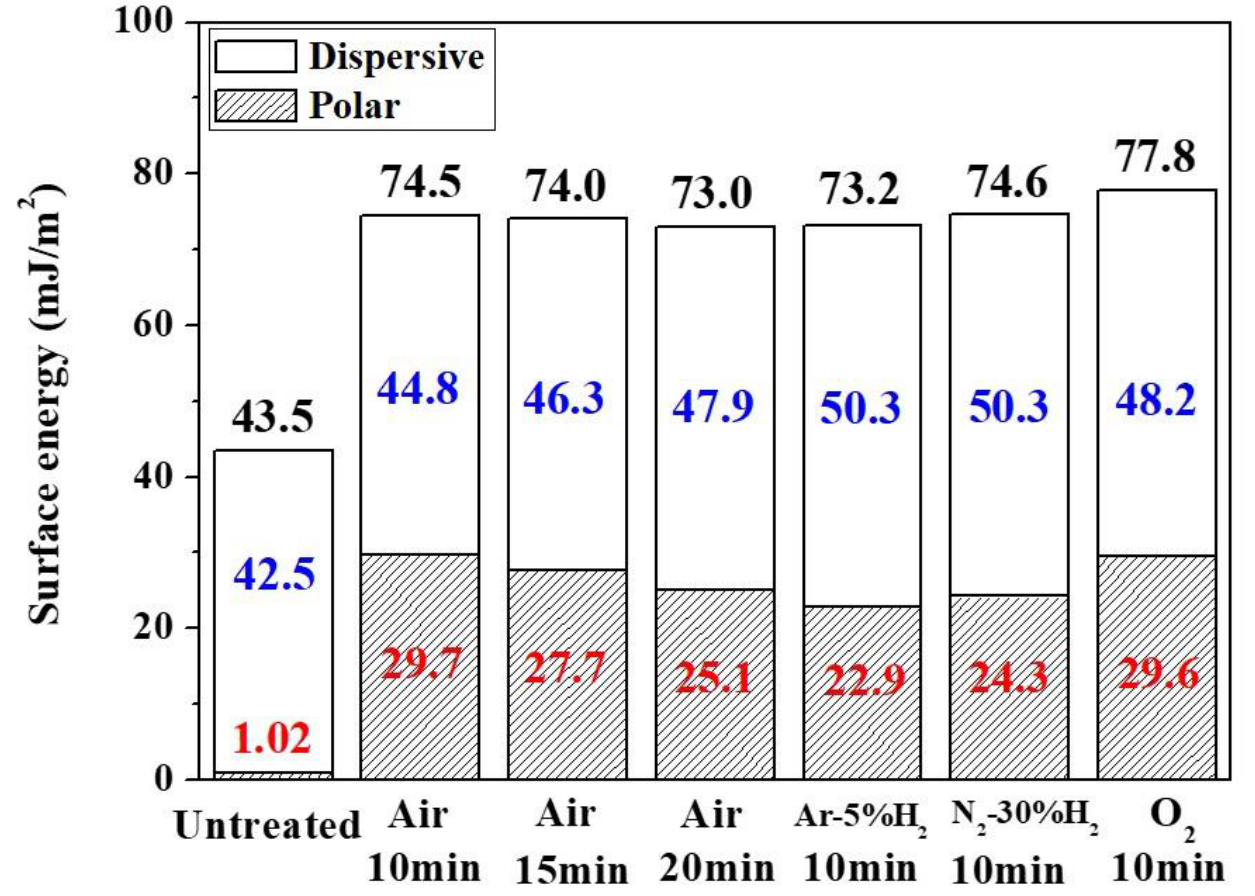
Figure 11. Surface energy of untreated PI substrates and others modified using different gas plas- mas. Table 2. Contact angle data.